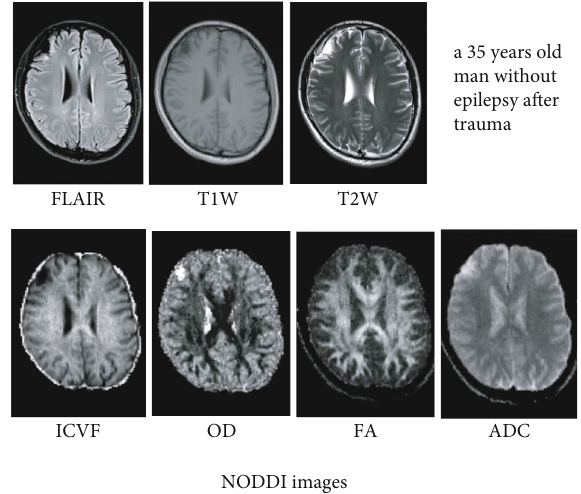
Figure 3: A 35-year-old man without epilepsy one year after trauma. He had softening foci with FLAIR hyperintense lesions in the right frontal lobe (FLAIR, T1W and T2W images, and NODDI ICVF, OD, FA, and ADC